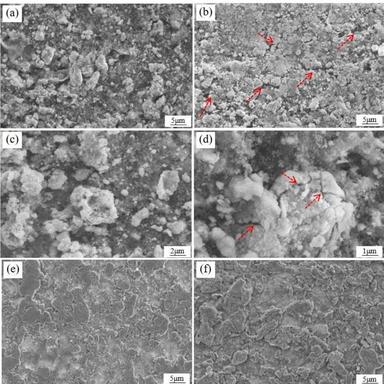
SEM images of the bare MnCO3 (a) before and (b) after 200 cycles, MnCO3/Mn3O4 (c) before and (d) after 200 cycles, graphene-wrapped MnCO3/Mn3O4 nanocomposite (e) before and (f) after 200 cycles.